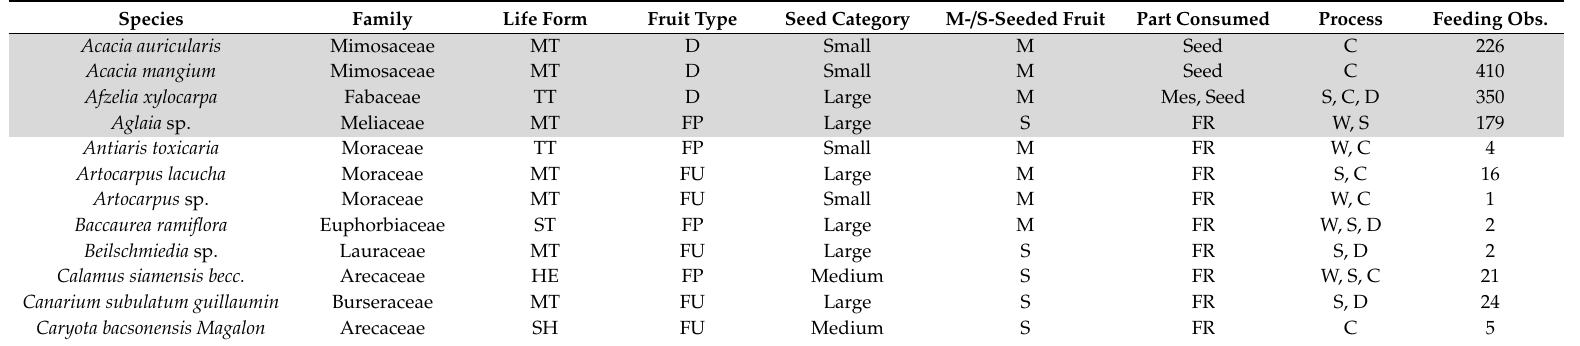
Table 2. Characteristics of the 107 fruit species included in the diet of the Macaca leonina Sakaerat troop. Species Family Life Form Fruit Type Seed Category M- / S-Seeded Fruit Part Consumed Process Feeding